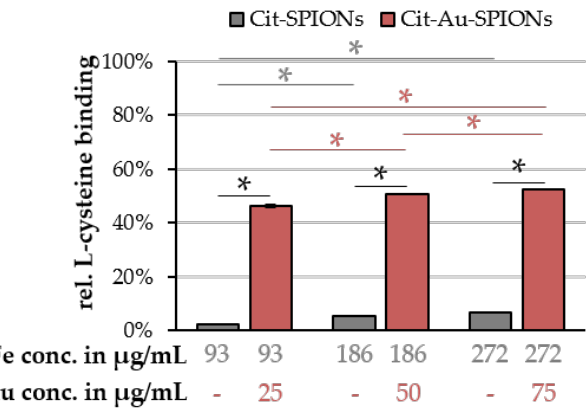
Figure 9. Relative L-cysteine binding to Cit-SPIONs and Cit-Au-SPIONs after incubation in a 1 mM L-cysteine solution for 2 h. Statistically significant changes are marked with * for p < 0.05. For Cit-SPIONs, the relative L-cysteine binding increased with higher particle concentrations from 2.3% ± 0.1% to 5.4% ± 0.4% and 6.6% ± 0.2% for concentrations of 93, 186 and 272 µg Fe/mL,